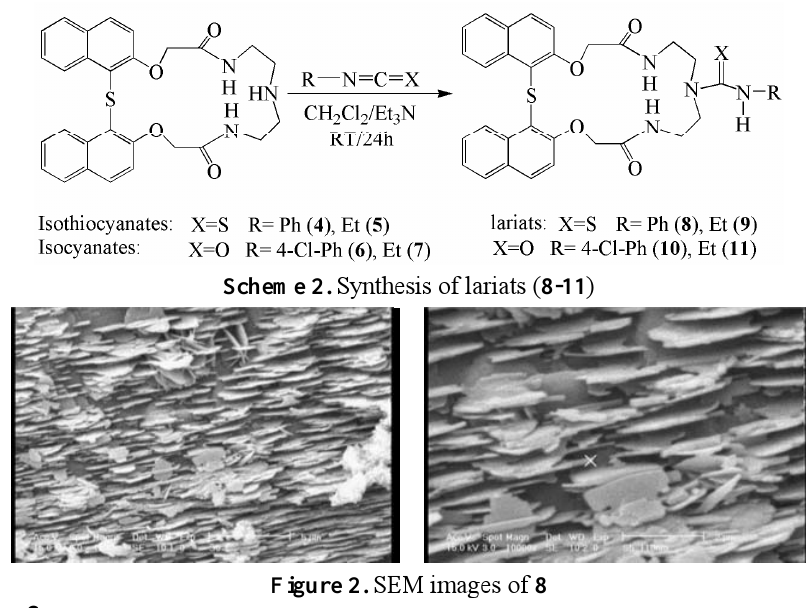
Figure 2. SEM images of